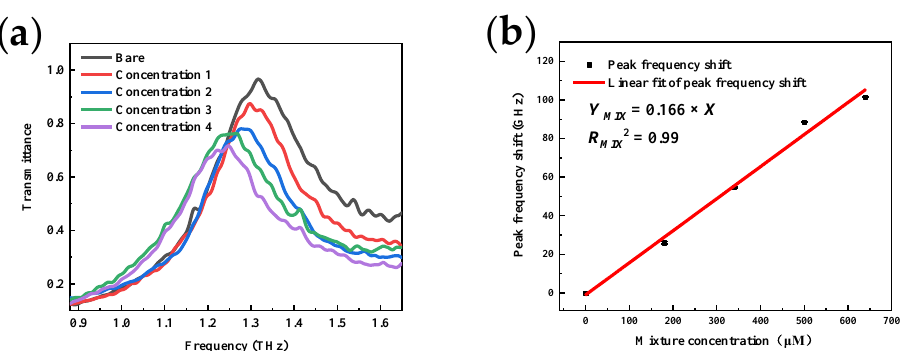
Figure 10. Detection results of the sensor’s resistant to ascorbic acid: ( a ) Peak frequency shift with the mixture of uric acid and ascorbic acid; ( b ) Sensor calibration curve in the mixture assay.